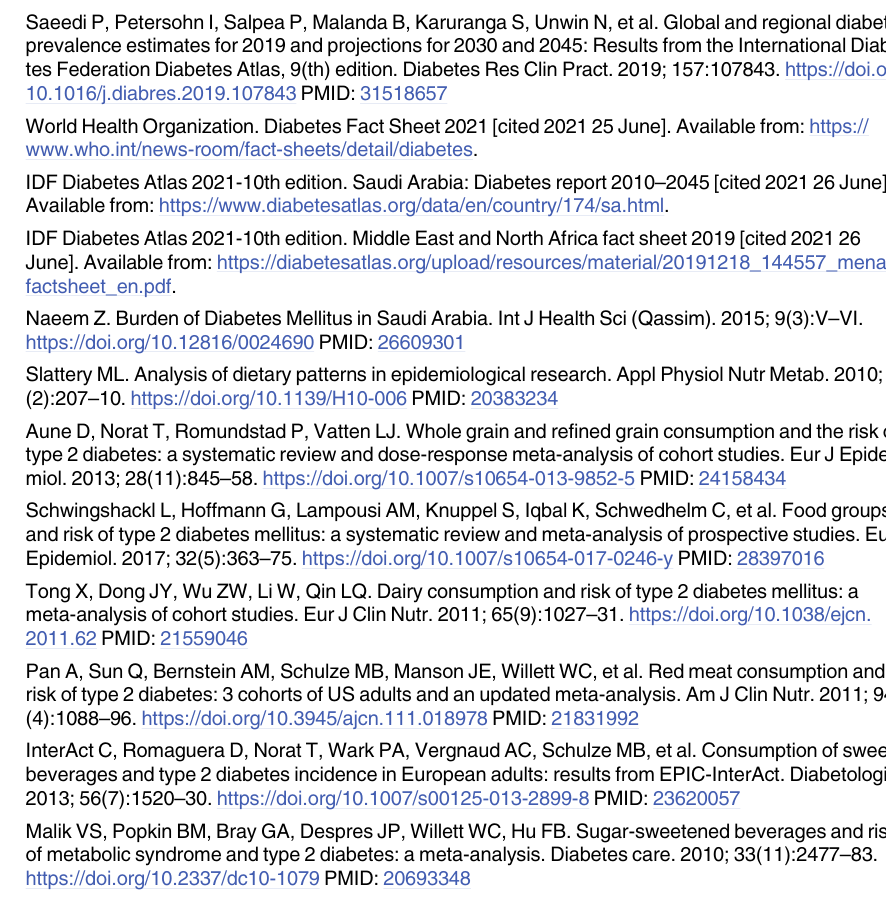
S1 Table. Food groupings used for dietary pattern